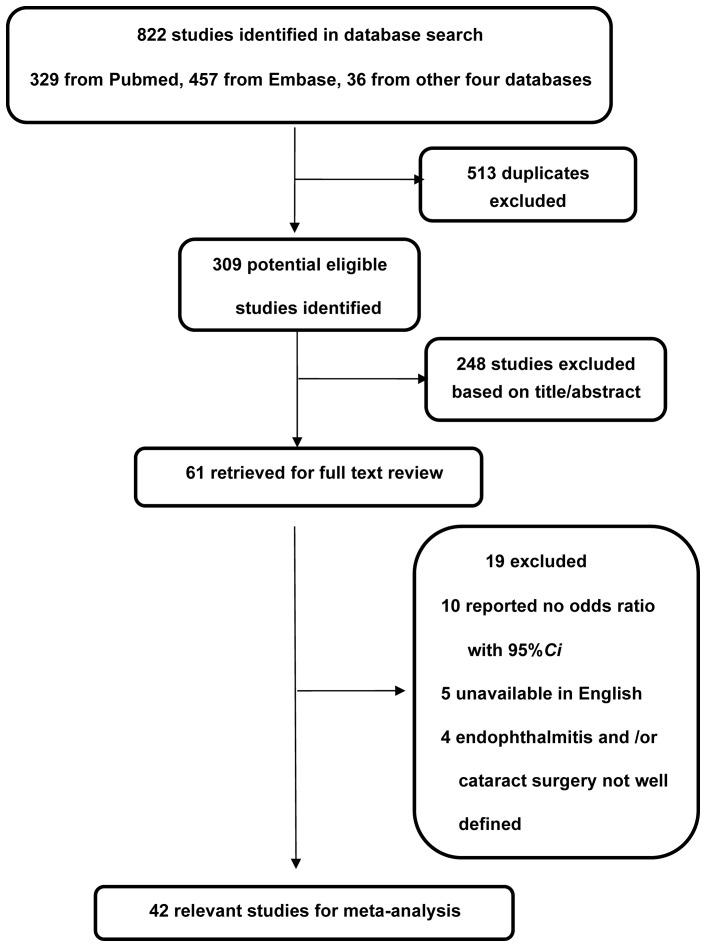
Flow diagram showing the selection process for inclusion of studies in the meta-analysis.CI  =  confidence interval.